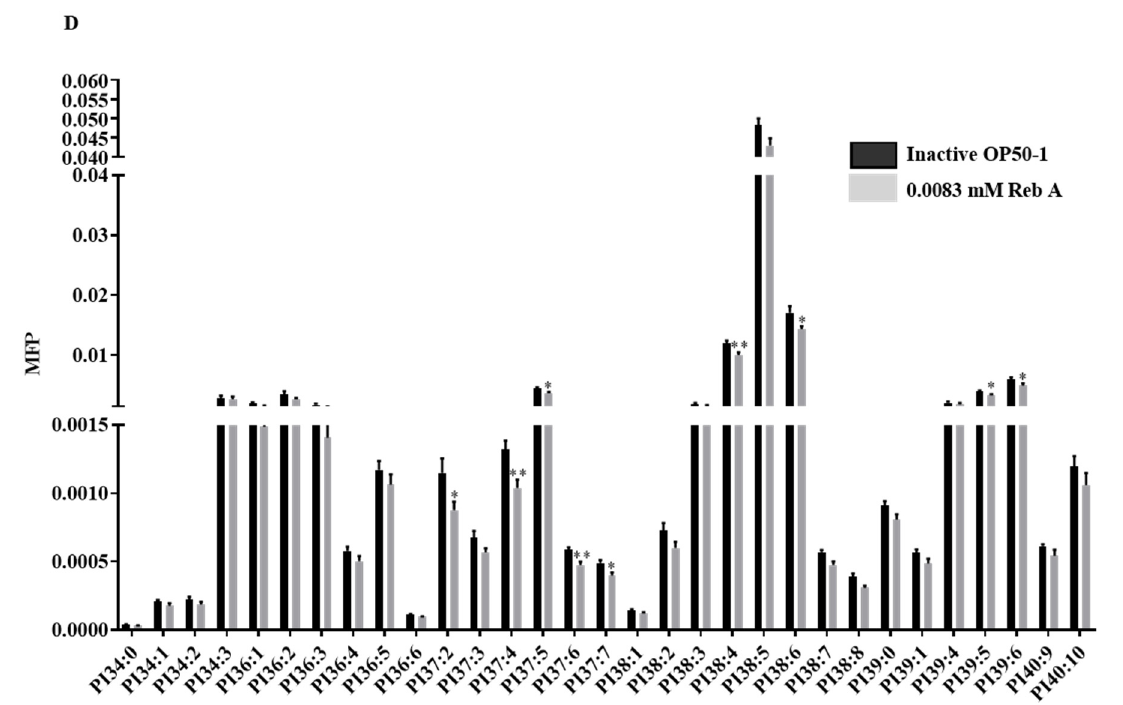
Figure 6. Reb A affects alters lipid metabolism of C. elegans . ( A ) The content of phosphatidylcholines (PGs), phosphatidic acids (PAs), cardiolipins (CLs), lysophosphatidylcholines (LPCs), LPS, lysophospholipinositols (LPIs), phosphatidylcholines (PCs), phosphatidylethanolamines (PEs), phosphatidylserines (PSs), lysophosphatidylethanolamines (LPEs), and phosphatidylinositiols (PIs) in the 10-day-old adults were analyzed by lipidomics, presented as molar fractions normalized to total polar lipids (MFP); ( B ) Profiles of LPCs in 10-day-old adult worms; ( C ) Profiles of PAs in 10-day-old adult worms; ( D ) Profiles of PIs in 10-day-old adult worms. Statistical significance was calculated by unpaired two-tailed t test. ** p < 0.001 and * p < 0.05.